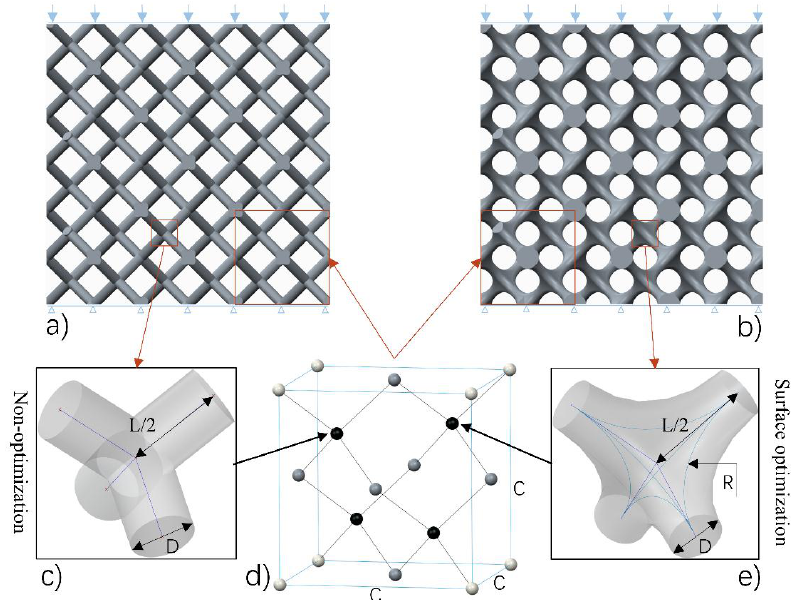
Figure 1. The experimental conditions: ( a ) sample 0600 without optimization, ( b ) sample 0616 with surface optimization at nodes (where ‘06’ denotes D = 0.6 mm, ‘16’ denotes R = 1.6 mm), ( c ) a node without optimization, ( d ) one of the unit cells used in the diamond-type 3 × 3 × 3 cellular structures, ( e ) a node with optimized surface.